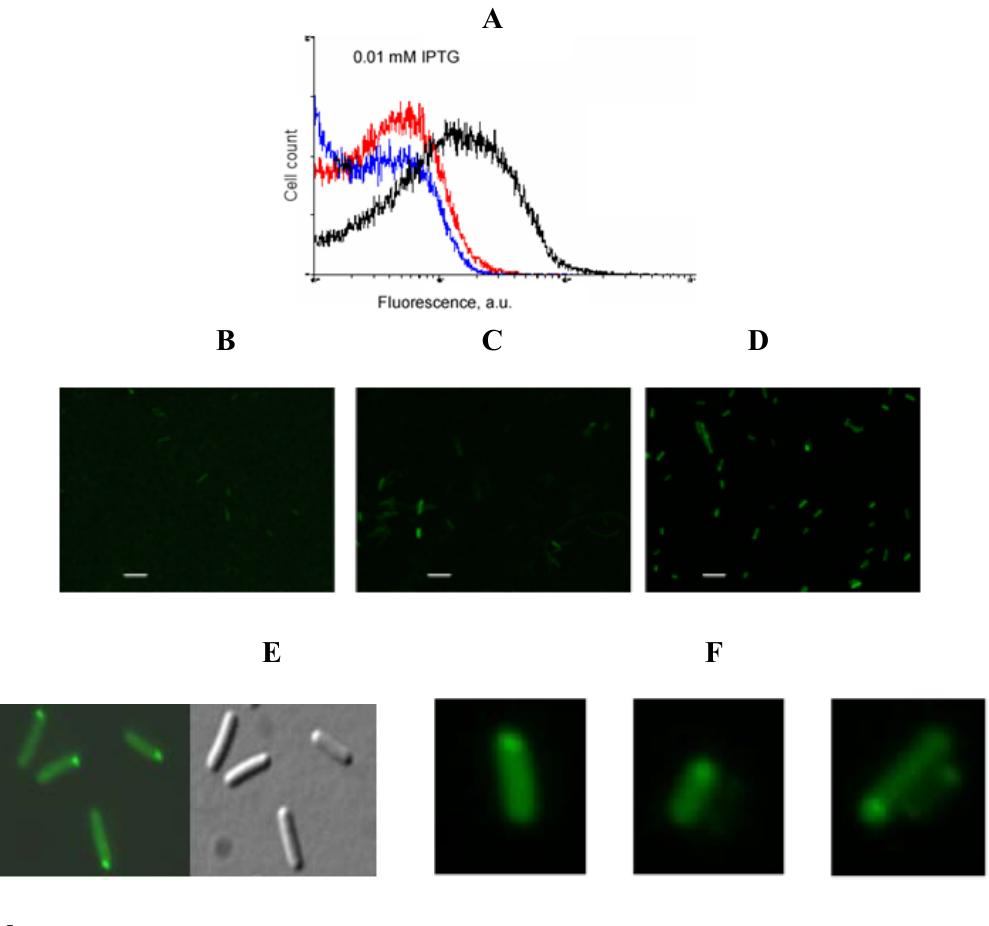
Figure 5. Fluorescent images of E. coli cells expressing RNA transcript tagged with the two aptamers. ( A ). FACS analysis of the E. coli cells: Blue, the cells express two fusion proteins in RNA absence; red, the cells express two fusion proteins and RNA aptamers with the wrong sequences (two HTLV-1 Rex aptamers); black, E. coli cells express two fusion proteins and RNA with two cognate aptamers; ( B ). Fluorescent microscopy: The control cells express fusion proteins in RNA absence; ( C ). the control cells express RNA with one non-cognate aptamer and fusion proteins; ( D ). the cells express fusion proteins and a transcript with two cognate aptamers. Scale bar, 5 μ m; all images were taken under similar conditions; ( E ). Fluorescence distributions in single E. coli cells expressing reporter RNA and labeled using eIF4A system [1]; ( F ). Fluorescence distributions in single E. coli cells expressing reporter RNA and labeled using binary viral peptide/aptamer system.